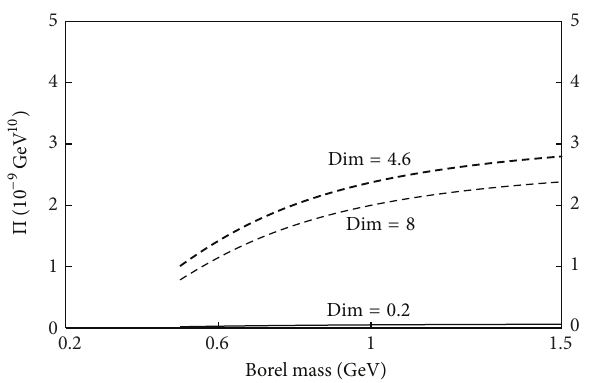
Figure 3: The solid curve shows the pole contribution and the dashed curve shows the continuum contribution ( =1 − pole con-